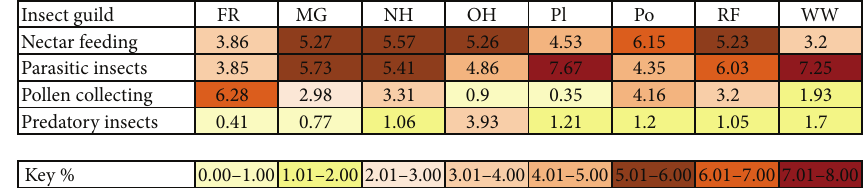
Figure 6: Heatmap-table summarising the relative abundance (%) of insect guild within each site, based on SIMPER analysis of count data recorded during the survey period. (FR) Flower Rich Grassland, Mown Grassland (MG), New Hedge (NH), Old Hedge (OH), Plantation Woodland (Pl), Pond (Po), Ridge and Furrow Grassland (RF), and Woodhorn Woodland (WW).